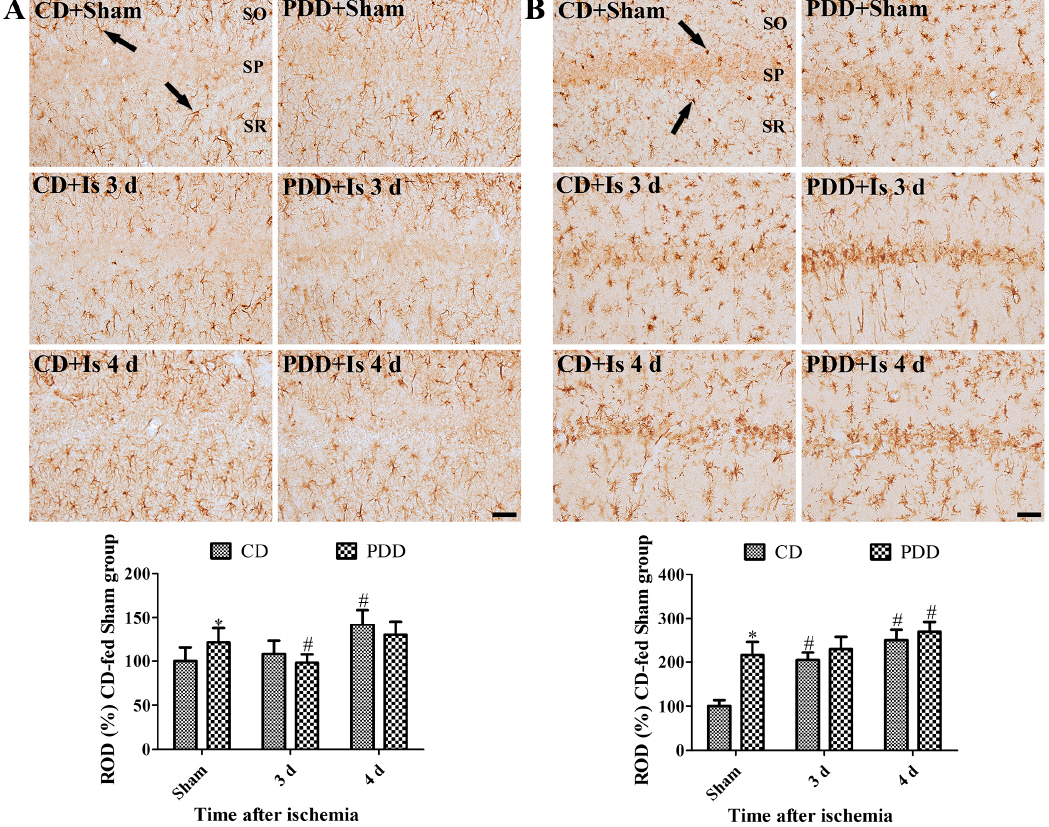
Figure 3. Immunohistochemical staining for GFAP ( A ) and Iba-1 ( B ) in the hippocampal CA1 region in the CD- and PDD-fed gerbils of sham- and ischemia-operated groups. Note that GFAP-immunoreactive astrocytes (arrows) and Iba-1-immunoreactive microglia (arrows) show morphological changes after PDD-diet and ischemic damage. SO, stratum oriens; SP, stratum pyramidale; SR, stratum radiatum. Scale bar = 50 μ m. Relative optical density (ROD) corresponding to the percentage of GFAP and Iba-1 immunoreactivity value in the hippocampal CA1 region of the CD-fed sham group per section is shown ( n = 7 per group; * p < 0.05, significant difference between CD- and PDD-fed groups; # p < 0.05, significant difference between sham- and ischemia-operated groups). All data are expressed as mean with standard deviation.